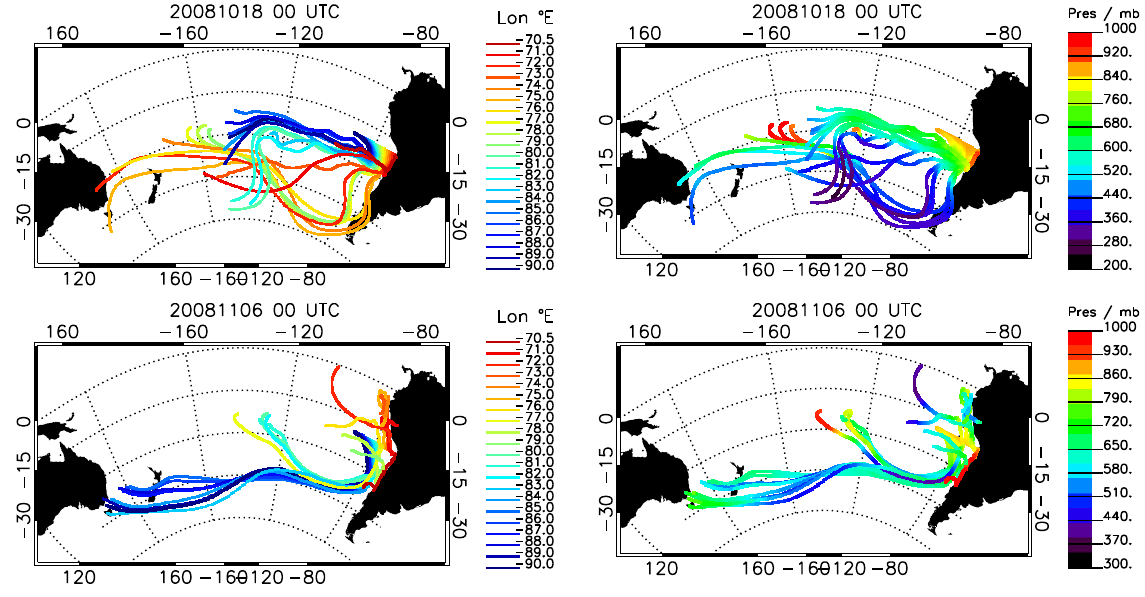
Fig. 2. Ten-day free tropospheric backward airmass trajectories ending at 850hPa along 20 ◦ S initiated at 0.5 degree intervals between 70.5 ◦ W and 90 ◦ W at 00:00UTC on 18 October 2008 (top) and 6 November 2008 (bottom). Left panels are colour-coded for longitudinal end-point, whilst right panels are colour-coded for pressure along each trajectory.